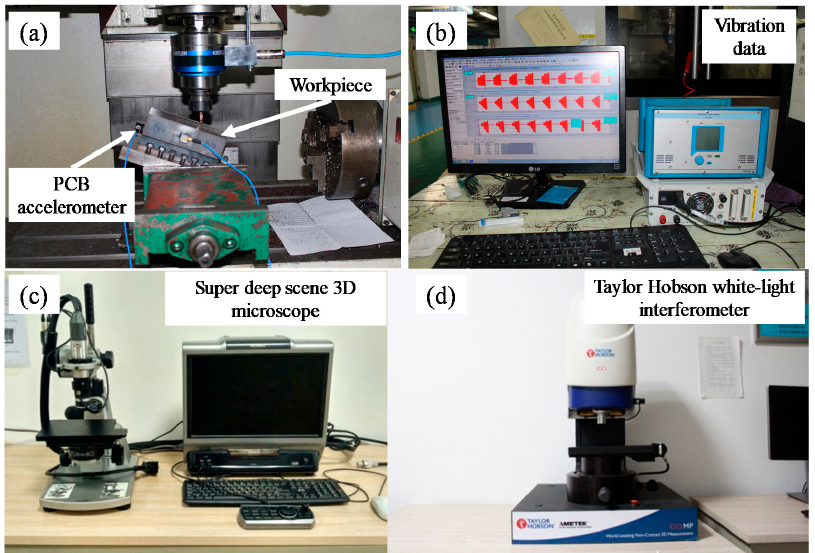
Figure 7. Experimental site ( a ) cutting process; ( b ) the collection of vibration data; ( c ) measurement of tool wear; ( d ) measurement of surface